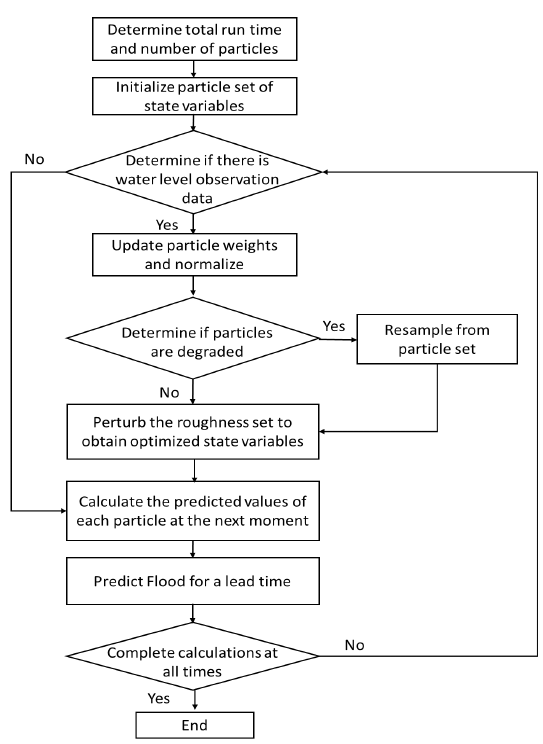
Figure 2. Flow chart of the hydrodynamic assimilation